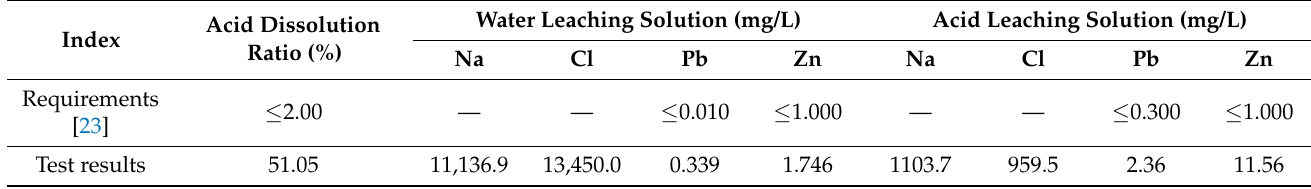
Table 4. Test results of direct leaching of fly